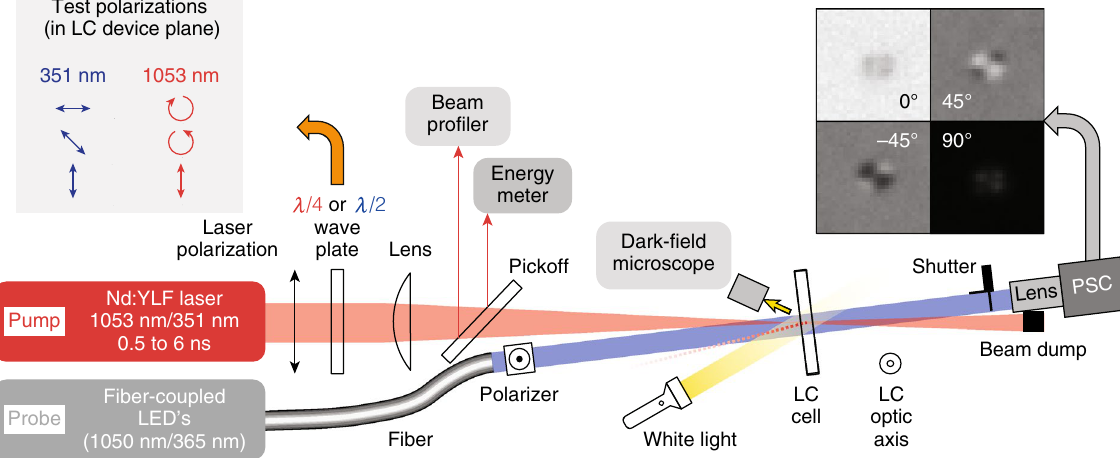
Figure 3. Schematic diagram of the nanosecond laser system used to conduct laser damage testing in oriented LC devices (PSC = polarization-sensitive camera). The optic axis orientation of the LC cell is in the plane of the substrate surfaces and orthogonal to the plane of the